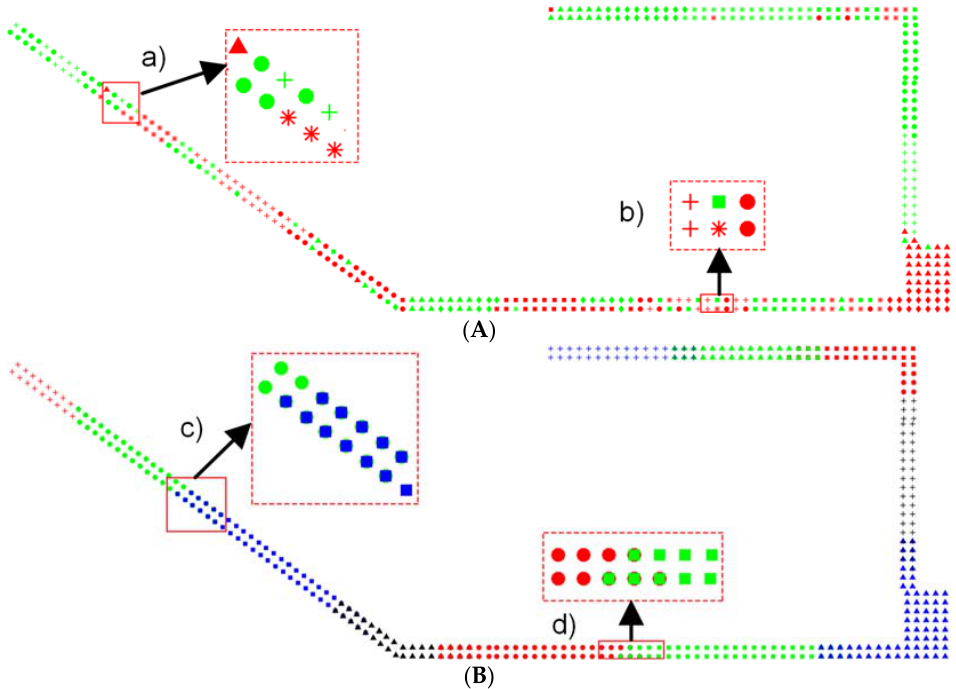
Figure 5. The clustering results of CFPD and IOFPD, where point marks mean different cluster results, ( A ) the clustering results of CFPD with several inaccurate cluster division; ( B ) the clustering results of IOFPD with adjusted transition regions.